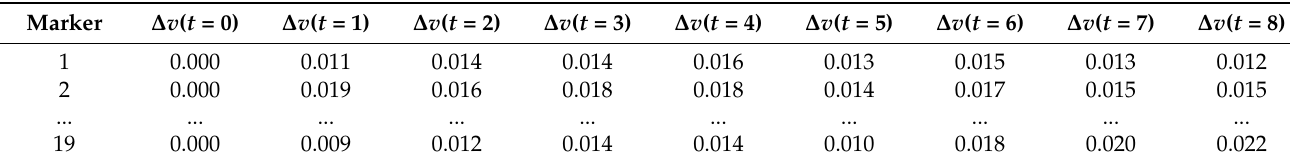
Table 16. Displacement intensity vector ∆ V